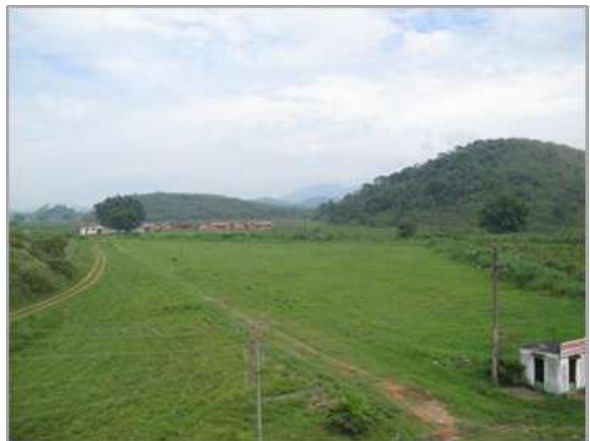
Figure 2. Types of vegetation – Pasture in Duque de Caxias city.